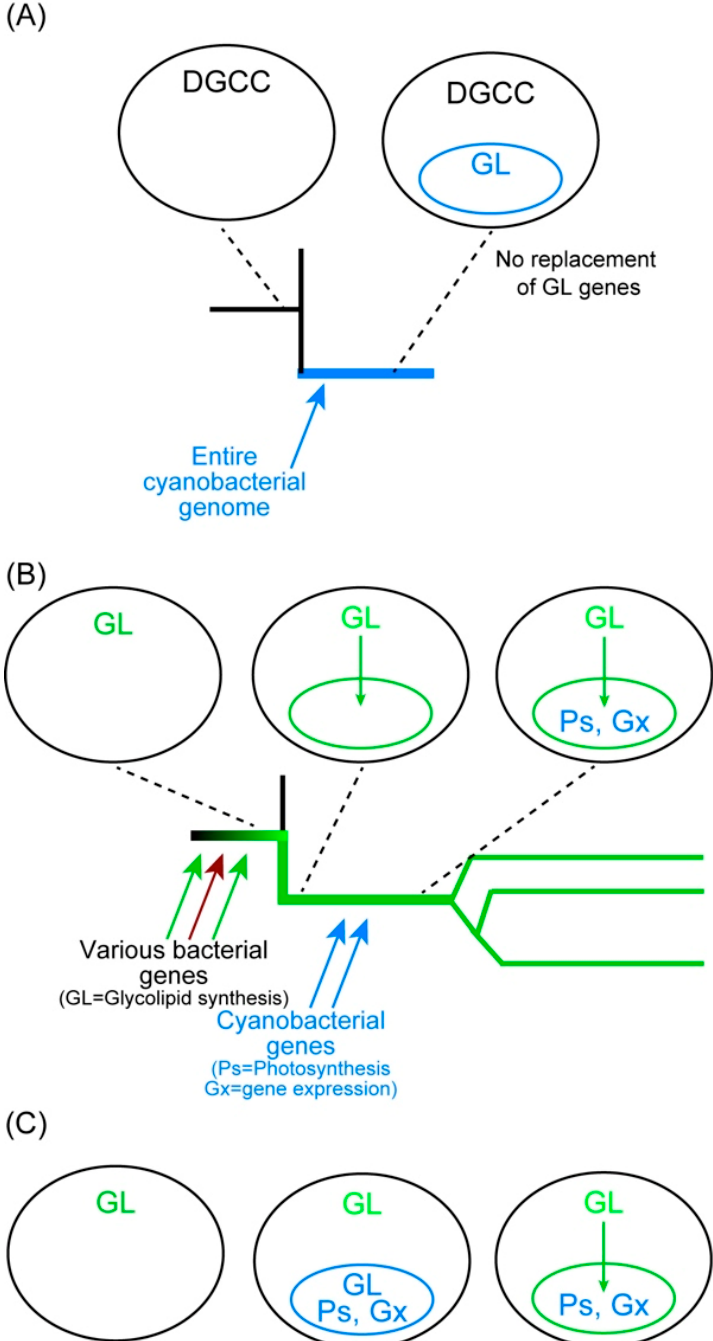
Figure 5. Unified schemes explaining the formation of membrane systems of ( A ) chromatophore and ( B , C ) chloroplast. The key components are phosphorus-free lipids. DGCC is a betaine lipid, and GL represents glycolipid trio (MGDG, DGDG, and SQDG). In scenario ( B ), glycolipids that were introduced as an adaptation to phosphate limitation form a membrane system, in which cyanobacterial photosynthesis and gene expression systems were incorporated. In scenario ( C ), the host cell acquired glycolipids before the cyanobacterial endosymbiosis, but then, the cyanobacterial glycolipid synthesis system was lost. Colors are used to indicate different lineages, such as cyan for cyanobacteria and green for